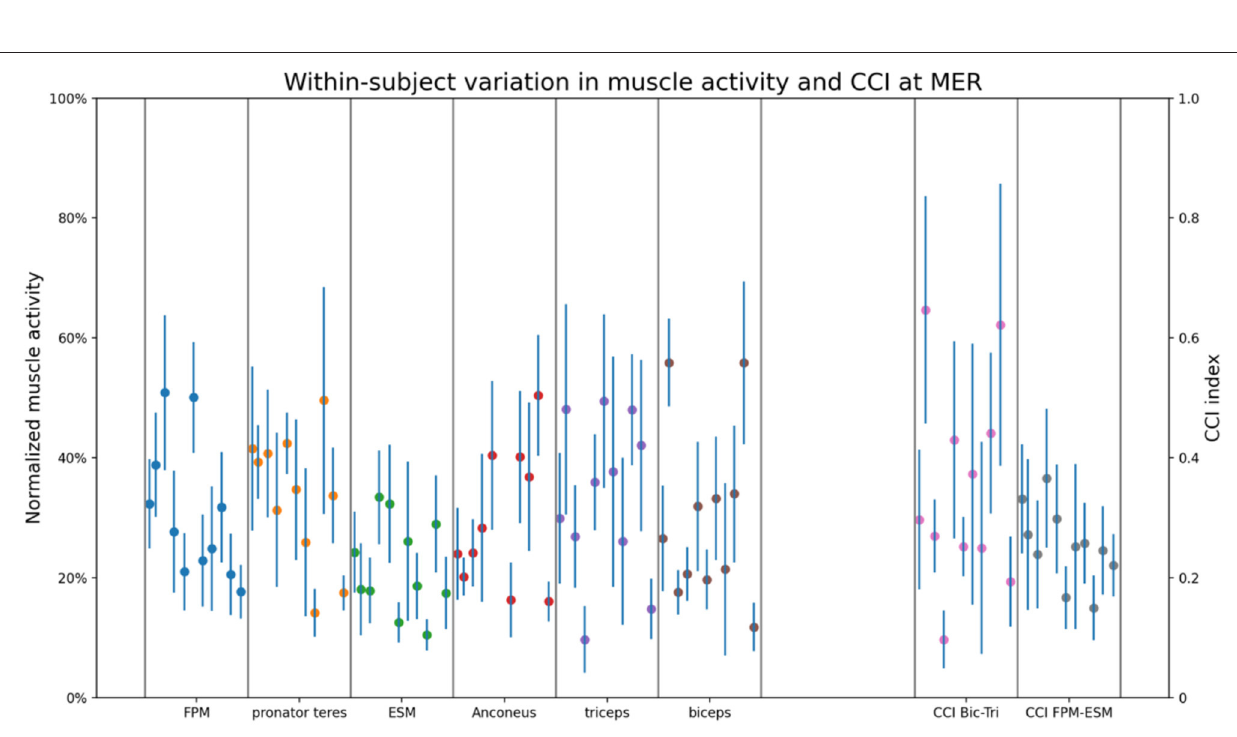
Frontiers in Sports and Active Living |